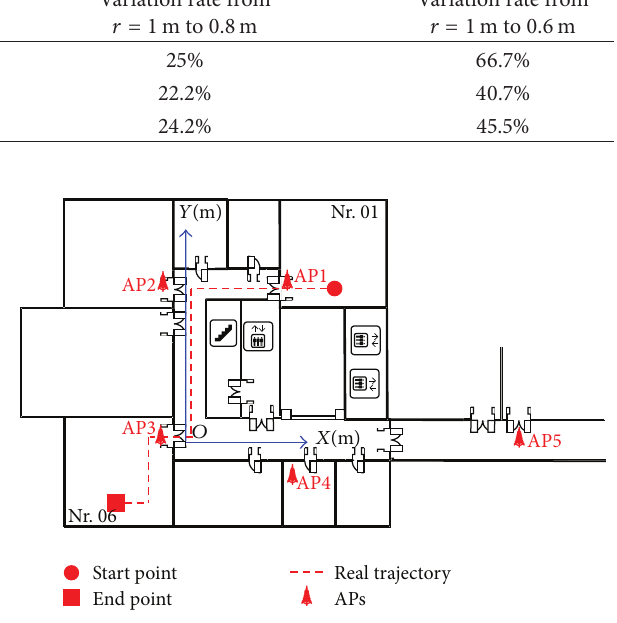
Figure 13: Real trajectory for dynamic positioning in Wi-Fi envi-